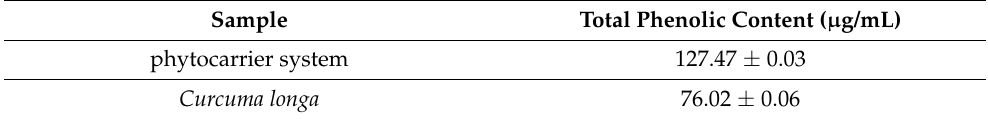
Table 6. Total polyphenolic content in curcuma and the phytocarrier